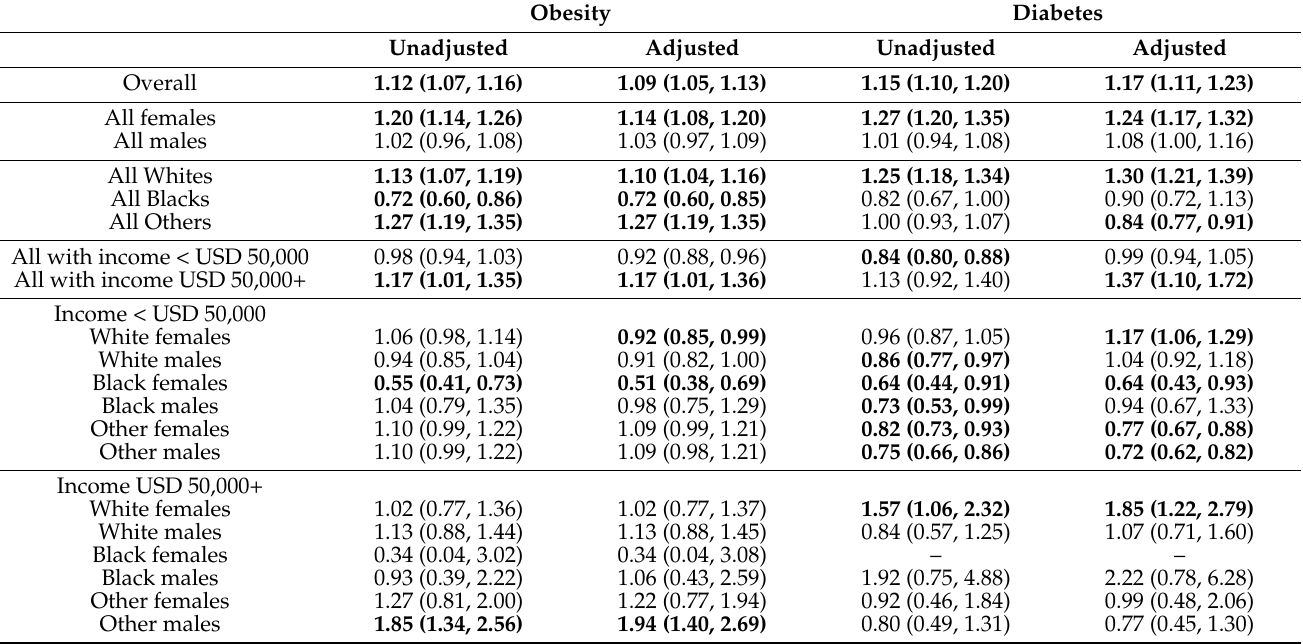
Boldface indicates statistically significant associations ( p <